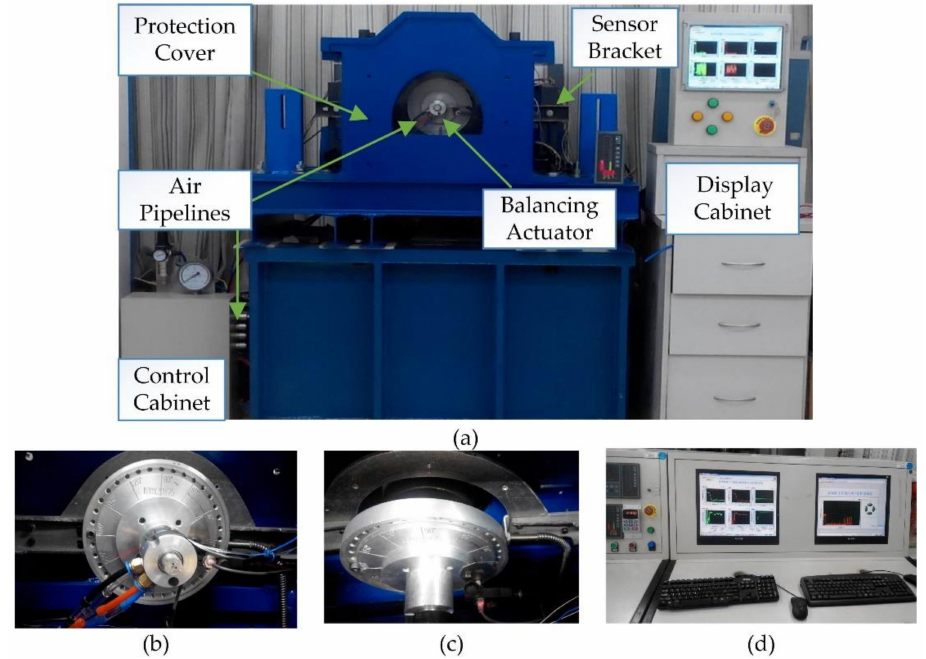
Figure 10. Test rig of the active balancing experiment. ( a ) overall experimental devices; ( b ) front view of the balance actuator; ( c ) vertical view of the balance actuator; and ( d ) control cabinet of the balancing system.